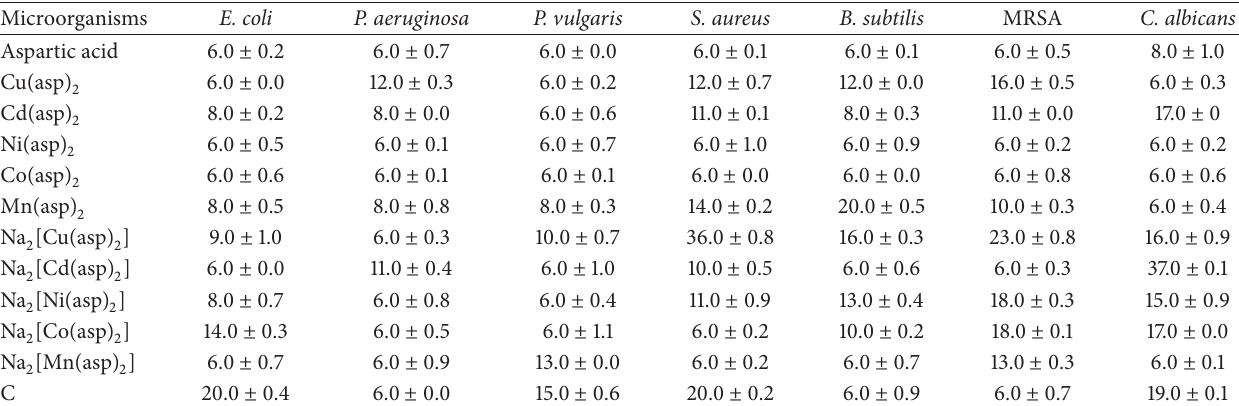
Table 4: Antimicrobial activities of the compounds.